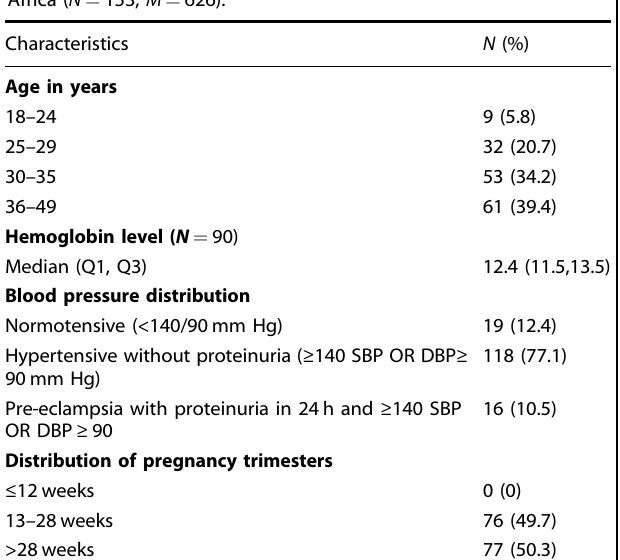
Table 1. Characteristics of pregnant population participants — South